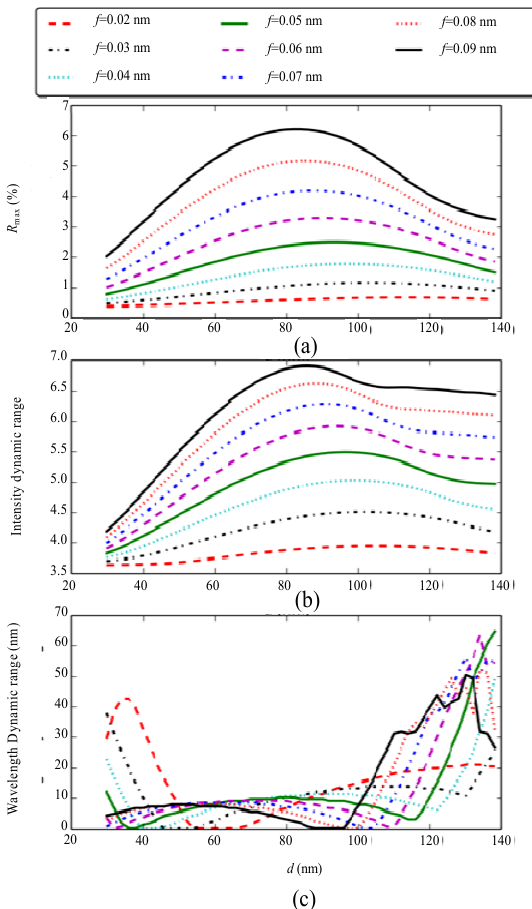
Fig. 5 Calculated (a) reflection peak, (b) intensity dynamic range, and (c) wavelength dynamic range as the function of the film thickness, d , at different volume fractions, f , for Au NPs in polymer( n h = 1.466).